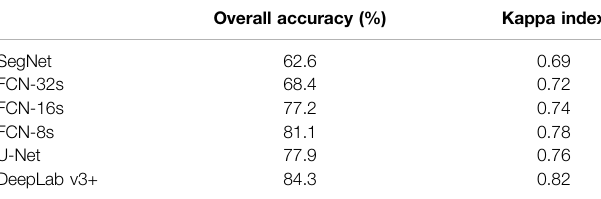
TABLE 3 | Overall accuracy and kappa index for the classi fi ers.